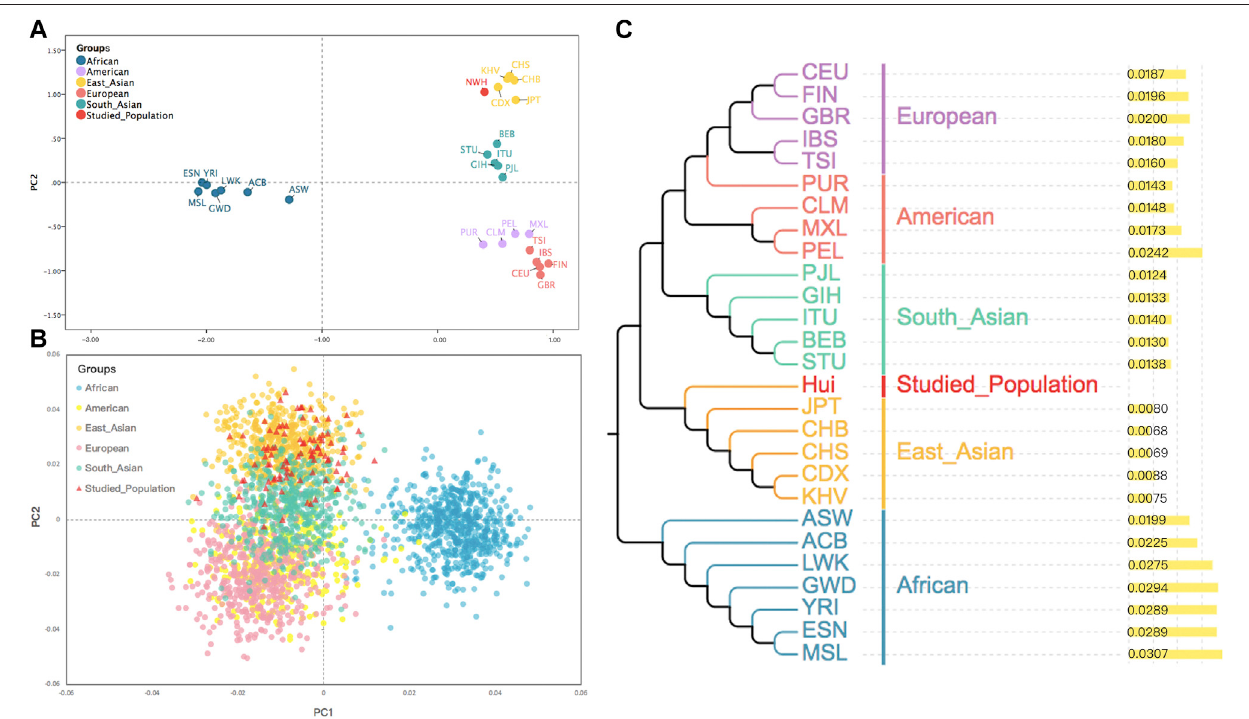
FIGURE3|(A) APCAplotoftheNorthwestHuigroupandthe26referencepopulationsbasedontheallelefrequenciesofthese93sameIISNPs. (B) APCAplotfor individuals from the Northwest Hui group and the 26 reference populations calculated based on the raw data of these 93 same IISNPs. (C) A neighbor-joining tree constructed based on the D A genetic distances of the Northwest Hui group and the 26 reference populations. PCA, principal component analysis; IISNPs, identity- informative single-nucleotide polymorphisms.